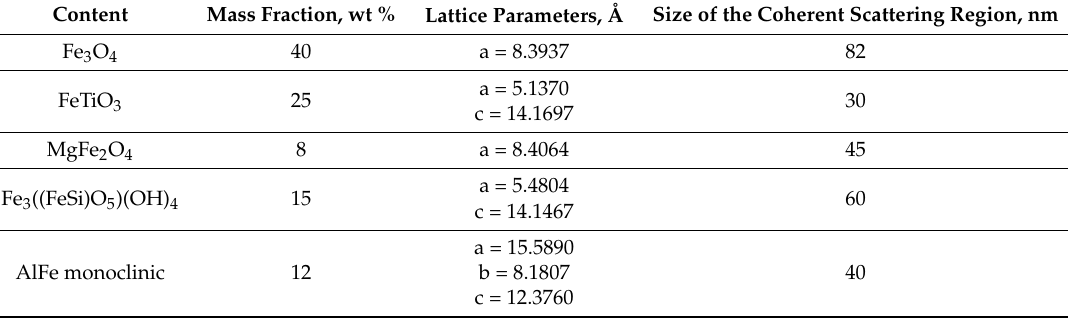
Table 2. Mineralogical composition of titanomagnetite ore from the Chineisk deposit by XRD (%). Content Mass Fraction, wt % Lattice Parameters, Å Size of the Coherent Scattering Region, nm